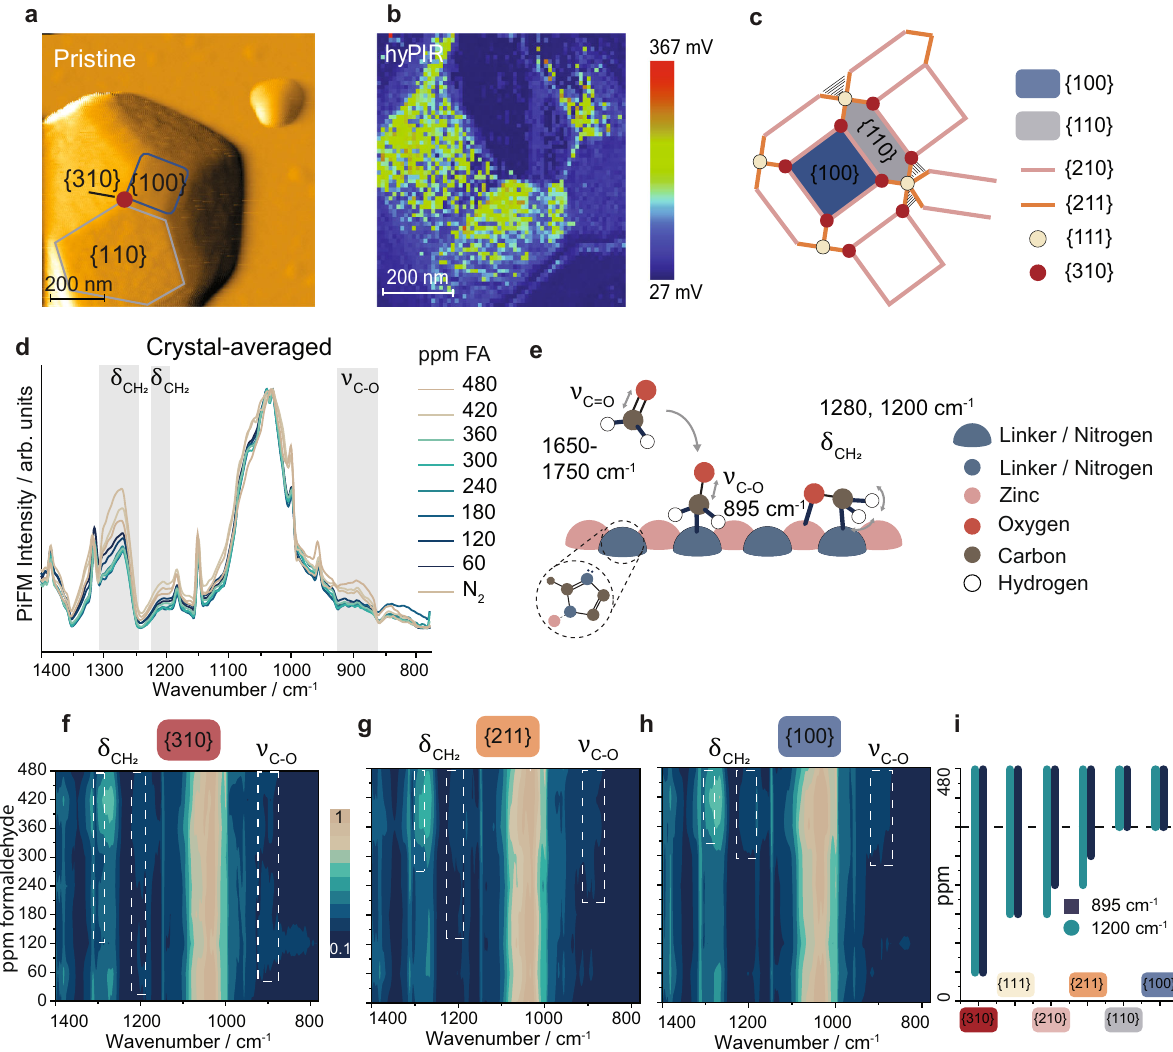
infrared bands,indicating gassorption. e Gas sorptionoccursbybreaking theC=O bondand forming acovalentC FA -N ZIF bond.Atthe sametime,FAiscoordinatedto theZnatomthroughanO-adduct.Contourplotsshowtheformaldehydesorption- induced change in the IR spectrum for a corner ( f ), an edge ( g ), and a facet plane ( h ). i Fromthecontourplots,responsepressurestoformaldehyde,i.e.,thepressure atwhicharesponsewasrecorded,forthesecrystalplaneswerefound,highlighting the structure-sensitive sorption of